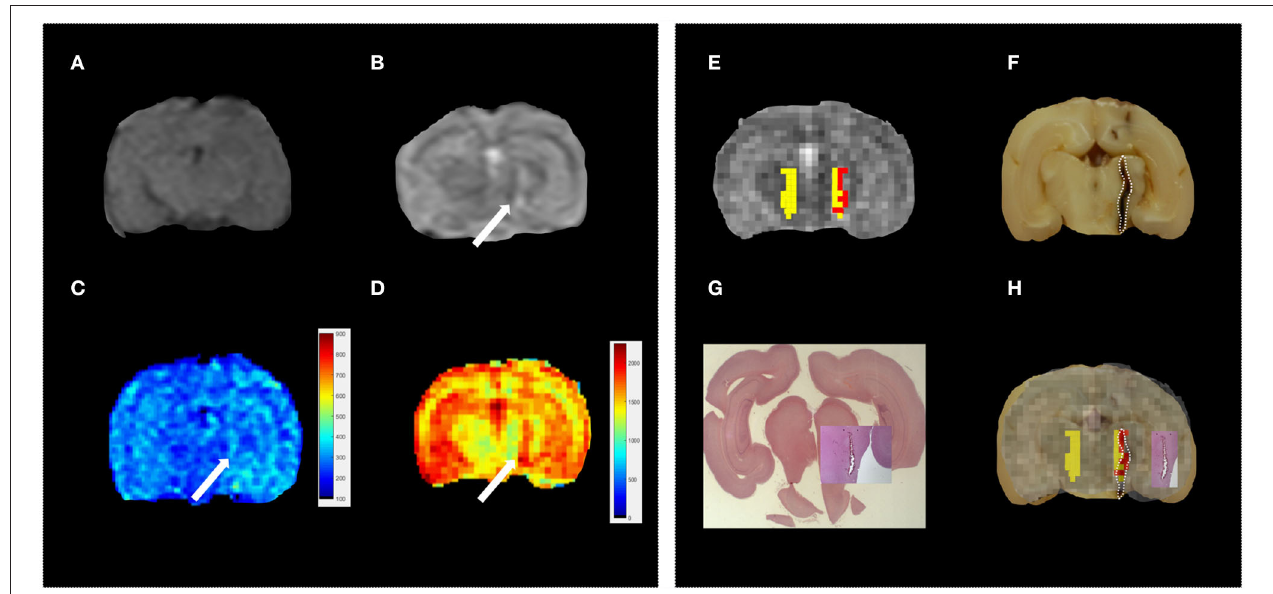
FIGURE 2 | Standard vs. MRR analyses and histopathological validation. Example 1. In all panels, the left brain hemisphere is shown on the right part of the image. (A) T1w transverse image of the brain; the lesion has been classified as “not visible,” (B) T2w transverse image of the brain; the lesion appears ill-defined, hyperintense, and linearly shaped in the left thalamus (white arrow), (C,D) T1 and T2 maps, respectively. A hyperintense linearly shaped area is visible in both maps (white arrow), (E) the output of the hierarchical cluster overlaid on the T2 map. Voxels classified as “pathological” and “healthy” parenchyma are reported in red and yellow, respectively, (F) the results of gross anatomy. From the photograph of the brain section, the contour of the hemorrhagic lesion characterized by a linear shape that mainly involves the left thalamus (white arrow) has been delineated (white dotted line), (G) Histopathology results with the overall brain section obtained from the microscope with the hemorrhagic lesion shown in greater detail superimposed on the overall section, and (H) the MRR classification compared to both gross anatomy and histopathology: voxels classified as pathological (red) fall inside the estimated true lesion